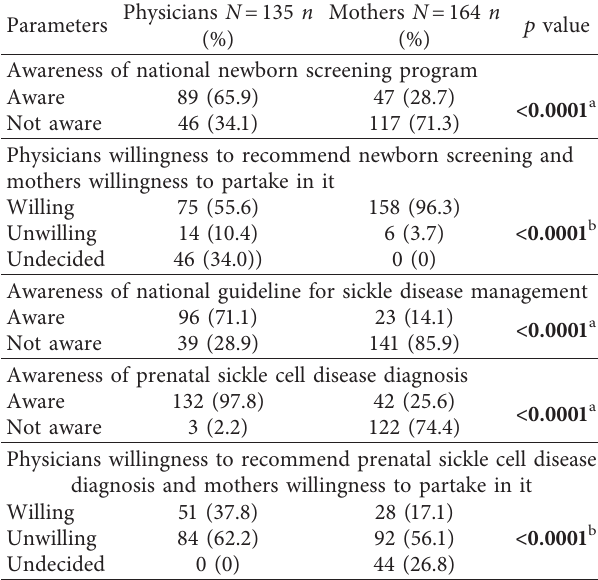
Table 3: Perceptions and practice of early diagnosis of sickle cell disease by